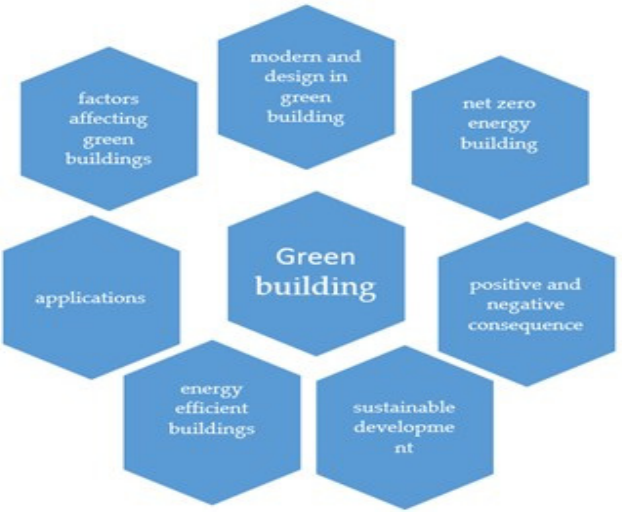
Figure 1. Various technologies and approaches, based on which, this review study has been con- ducted.